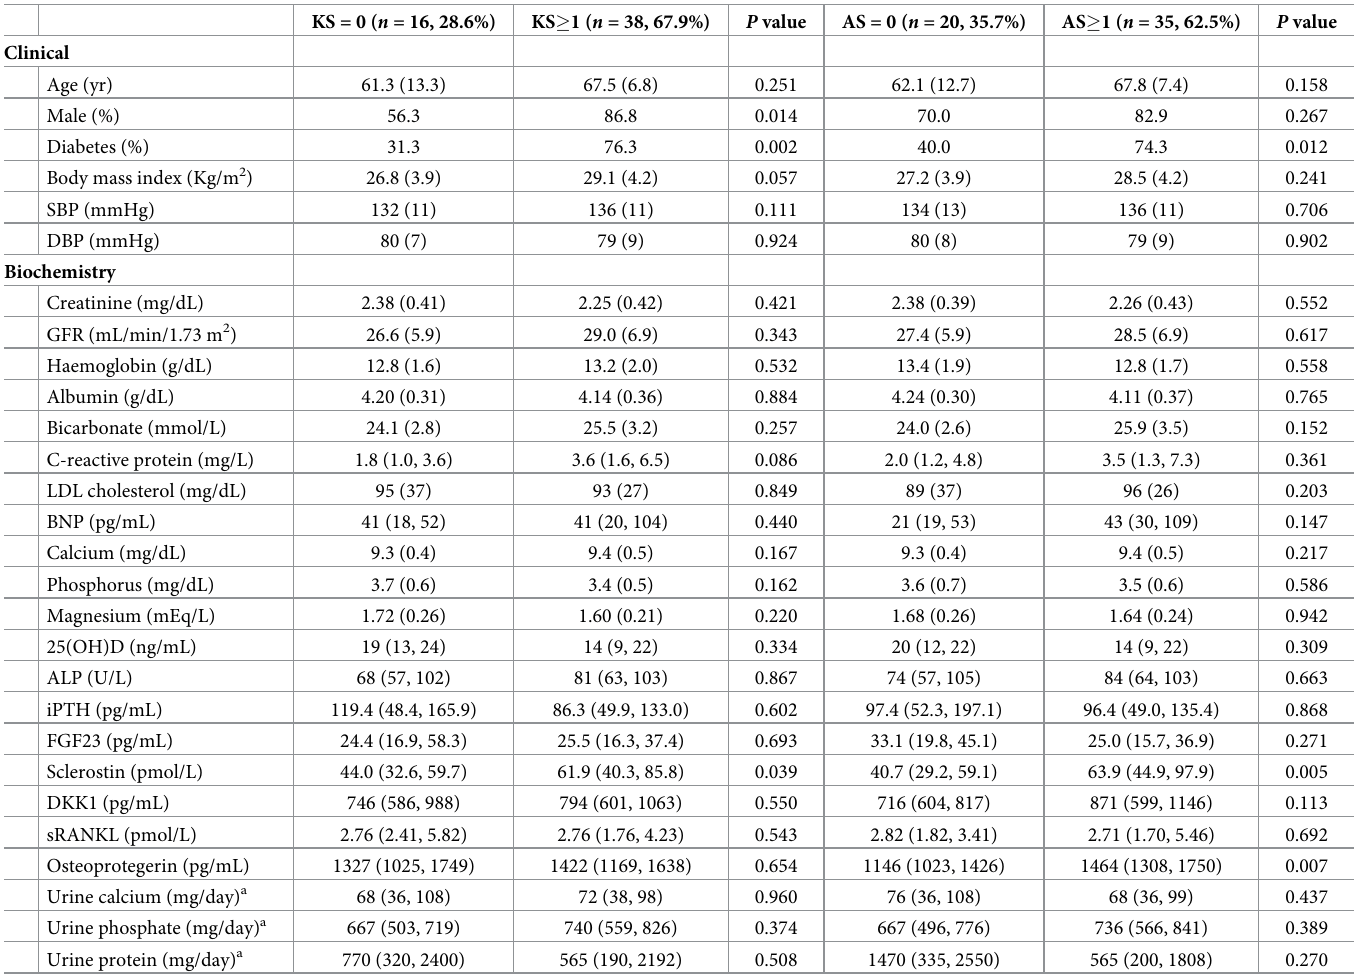
Table 2. Demographic, clinical and laboratory characteristics of the study population according to the presence or absence of vascular calcification. KS = 0 ( n = 16,